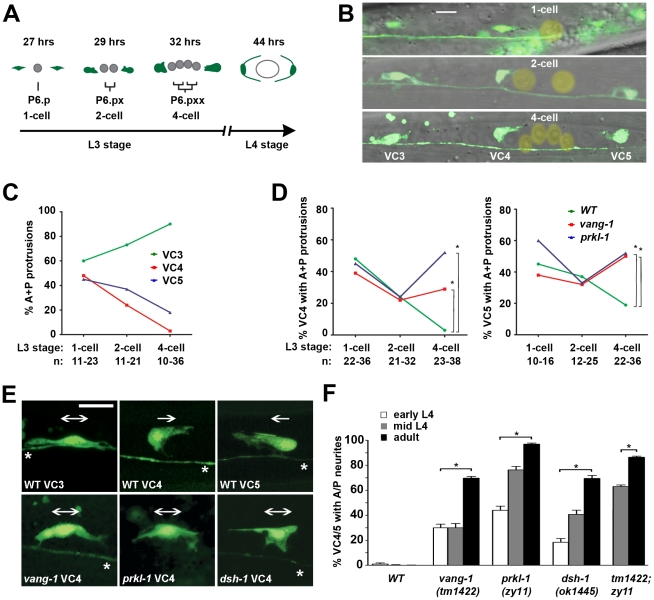
PCP-like signaling maintains VC4 and VC5 polarity after a bipolar to unipolar reorientation along the A/P axis.(A) Simplified schematic showing a timeline (hours post-hatching) of VC4 and VC5 neuritogenesis and vulval organogenesis from early L3 to mid-L4 (see also Figure S1). Division of the P6.p vulval precursor cell (VPC) was used as milestones for staging during L3. (B) Representative merged fluorescence and DIC images showing the morphology of VC3, VC4, and VC5 at the 1-cell, 2-cell and 4-cell P6.p VPC stages. P6.p and its descendents are marked with a yellow overlay. (C and D) From the 1-cell to the 4-cell stage in wild-type animals, the proportion of neurons displaying an A/P-elongated bipolar morphology progressively increases for VC3 and decreases for VC4 and VC5 (C). In PCP mutants, a significant proportion of VC4 and VC5 neurons display an A/P bipolar morphology compared to wild-type by the 4-cell stage (D), suggesting that PCP signaling is required early during neuritogenesis to restrict neurite emergence. *p<0.05, Fisher's Exact test. (E) Representative micrographs at the 4-cell stage reveal that VC4 and VC5, normally polarized unidirectionally toward the vulval axis of symmetry (unipolar arrows), resemble the A/P bipolar morphology of VC3 in vang-1, prkl-1 and dsh-1 mutants (bipolar arrows). (F) In PCP mutants, VC4 and VC5 display a gradual loss in polarity during development suggesting that PCP signaling is required to maintain polarized morphology. Error bars represent standard error of proportion; n>100. *p<0.001, χ2. VC neurons in B and D visualized using a cyIs3[Punc-4::GFP] reporter. Scale bar, 10 µm.